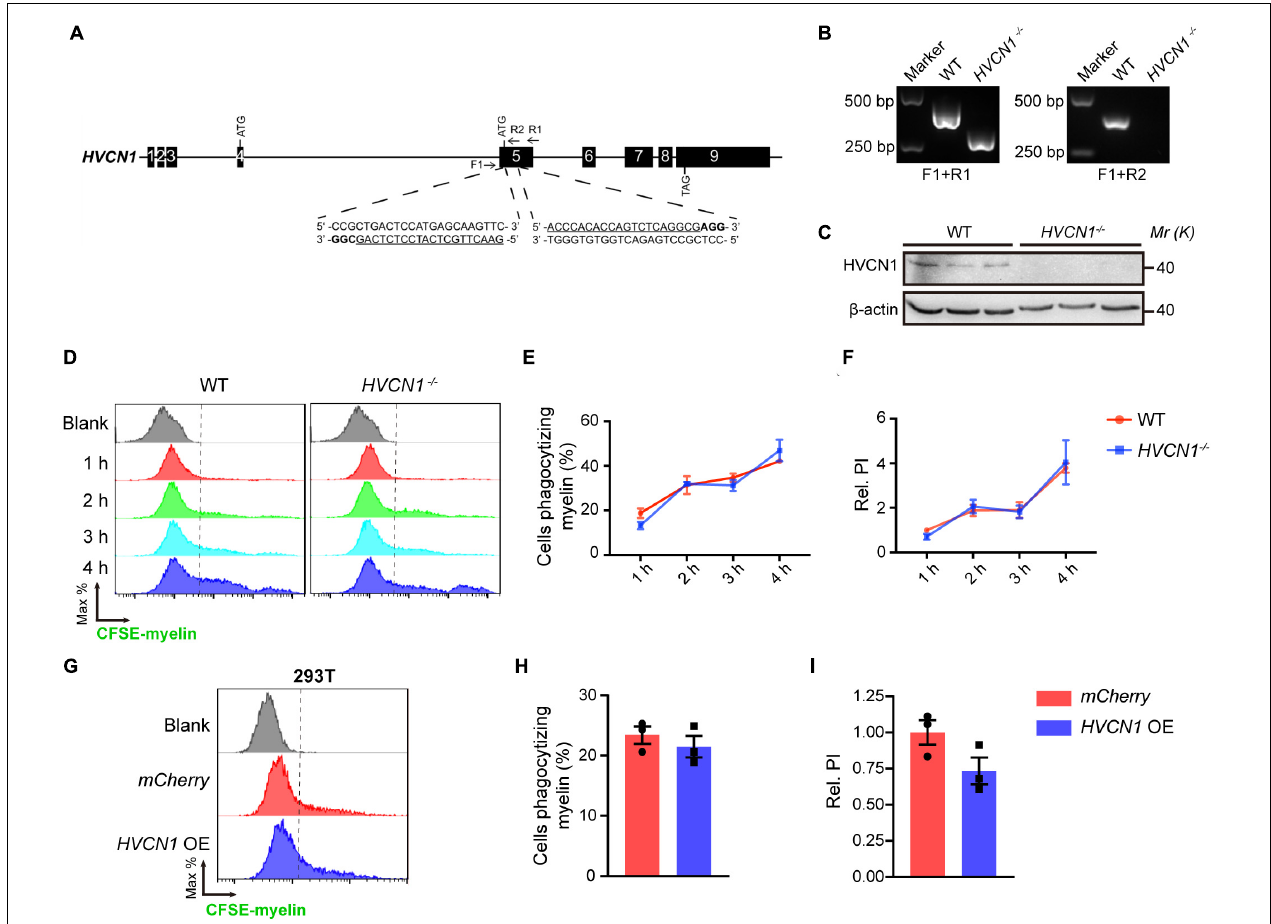
FIGURE 6 | Both genetic deletion and overexpression of HVCN1 do not affect phagocytosis of myelin in 293T cells. (A) HVCN1 gene knockout strategy by CRISPR/Cas9 in 293T cells. Black boxes, exons; line, introns; Arrows, primers for PCR detection; Underlined, sgRNA targeted sequences; Bold, PAM. (B) Genomic PCR products of WT and HVCN1 − / − 293T cells. The position of primers is shown in (A) . (C) Western blot images of HVCN1 in WT and HVCN1 − / − 293T cells. (D–F) Flow cytometry chart (D) and the quantification graphs (E,F) : HVCN1 knockout does not affect both the proportion of cells phagocytizing myelin (E) and the relative phagocytic index (F) in CFSE-labeled-myelin phagocytosis assay in 293T cells ( n = 3). (G–I) Flow cytometry chart (G) and the quantification graphs (H,I) show that overexpression of HVCN1 does not affect both the proportion of cells phagocytizing myelin (H) and the relative phagocytic index (I) in CFSE-labeled-myelin phagocytosis assay in 293T cells ( n = 3). Data are presented as mean ± SEM. Statistical tests: two-way ANOVA with Sidak’s multiple comparison posttest (E,F) or unpaired two-tailed t -test (H,I)